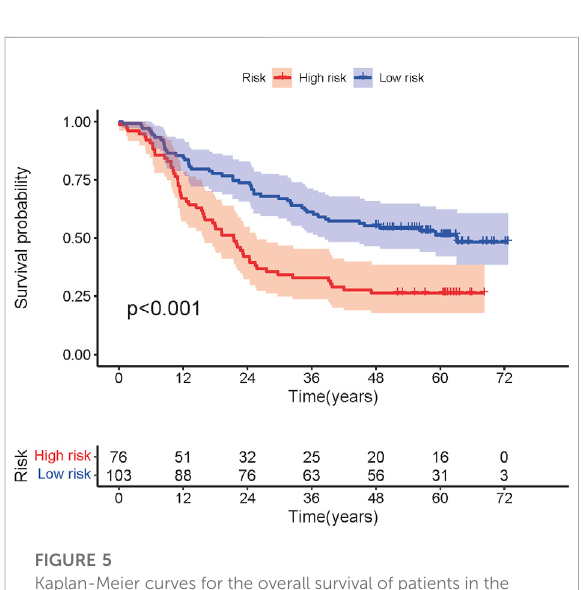
FIGURE 5 Kaplan-Meier curves for the overall survival of patients in the high- and low-risk